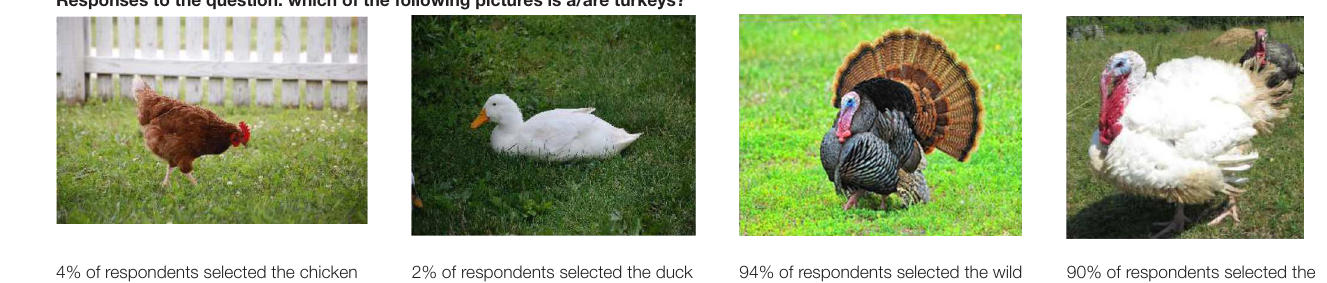
TABLE 4 | Respondent identification of pictures a of turkeys ( N = 1,695). Responses to the question: which of the following pictures is a/are